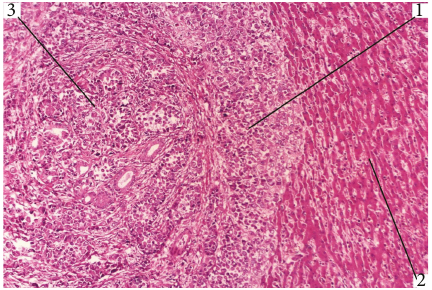
Figure 2: Undi ff erentiated cancer in the setting of SO. Opposition growth. HE staining, magni fi cation 200x (1: undi ff erentiated tumour cells; 2: normal liver cells; 3: cholangiocyte adenomatous